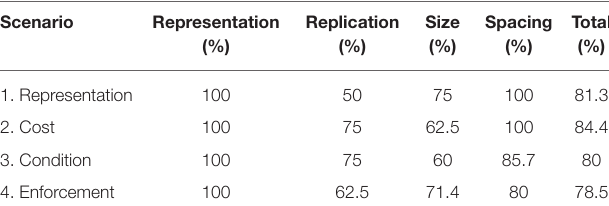
TABLE 7 | Percentage accomplished of each MLPA criteria (habitat representation, habitat replication, size of MPAs, and spacing between MPAs) and the total criteria fulfilled in each scenario based on the best solution of 100 runs with Marxan. Scenario